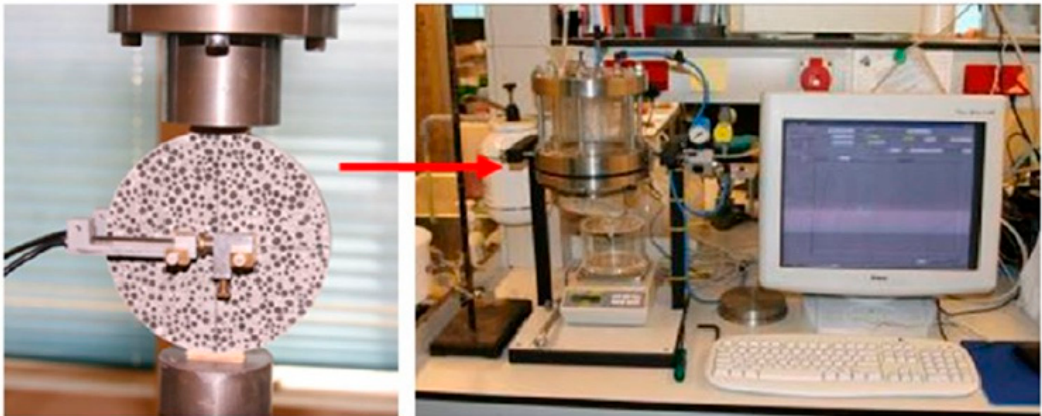
Figure 4. Pre-cracking of the concrete slab and subsequent permeability testing Error! Reference source not found.